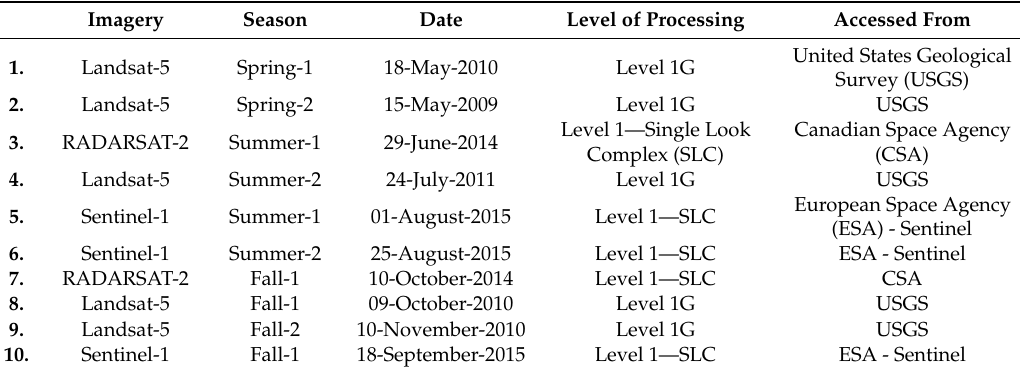
Table 1. Summary of remotely-sensed imagery collected for this